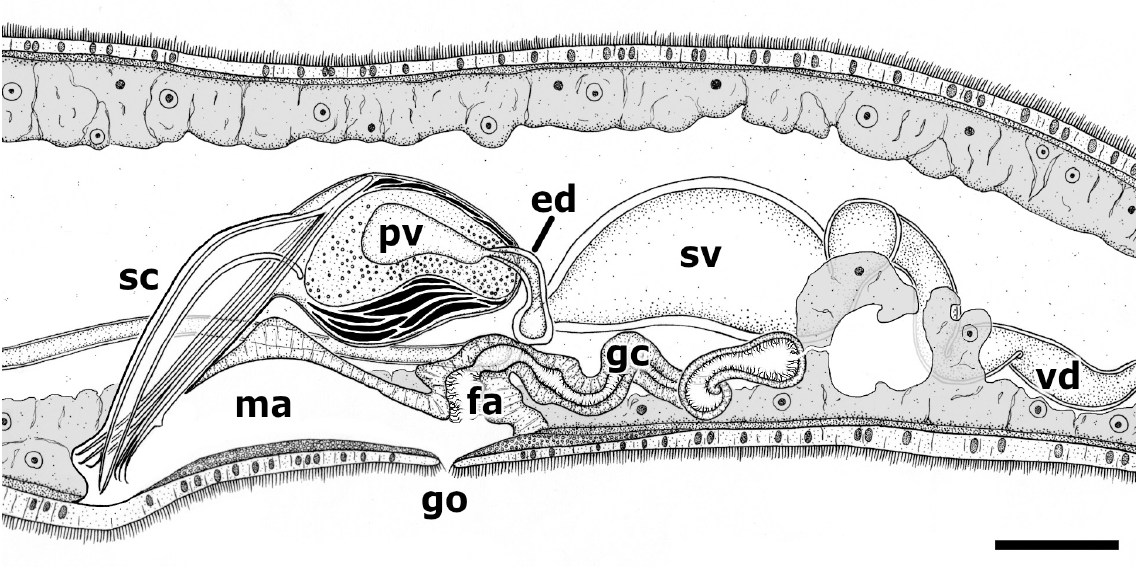
Fig. 3. Reconstruction of the reproductive complex of Coelogynopora kenichii sp. nov., based on a series of sagittal sections. For the sake of clarity, a single seminal vesicle and ovovitelline duct were drawn, and gland cells were omitted (RMNH.VER.19980.l). Scale bar = 30